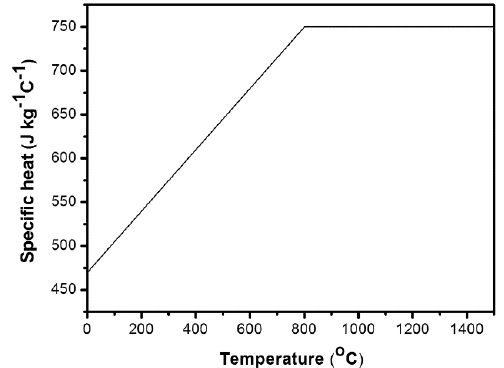
Figure 2. Temperature-dependent specific heat for base and weld metal.